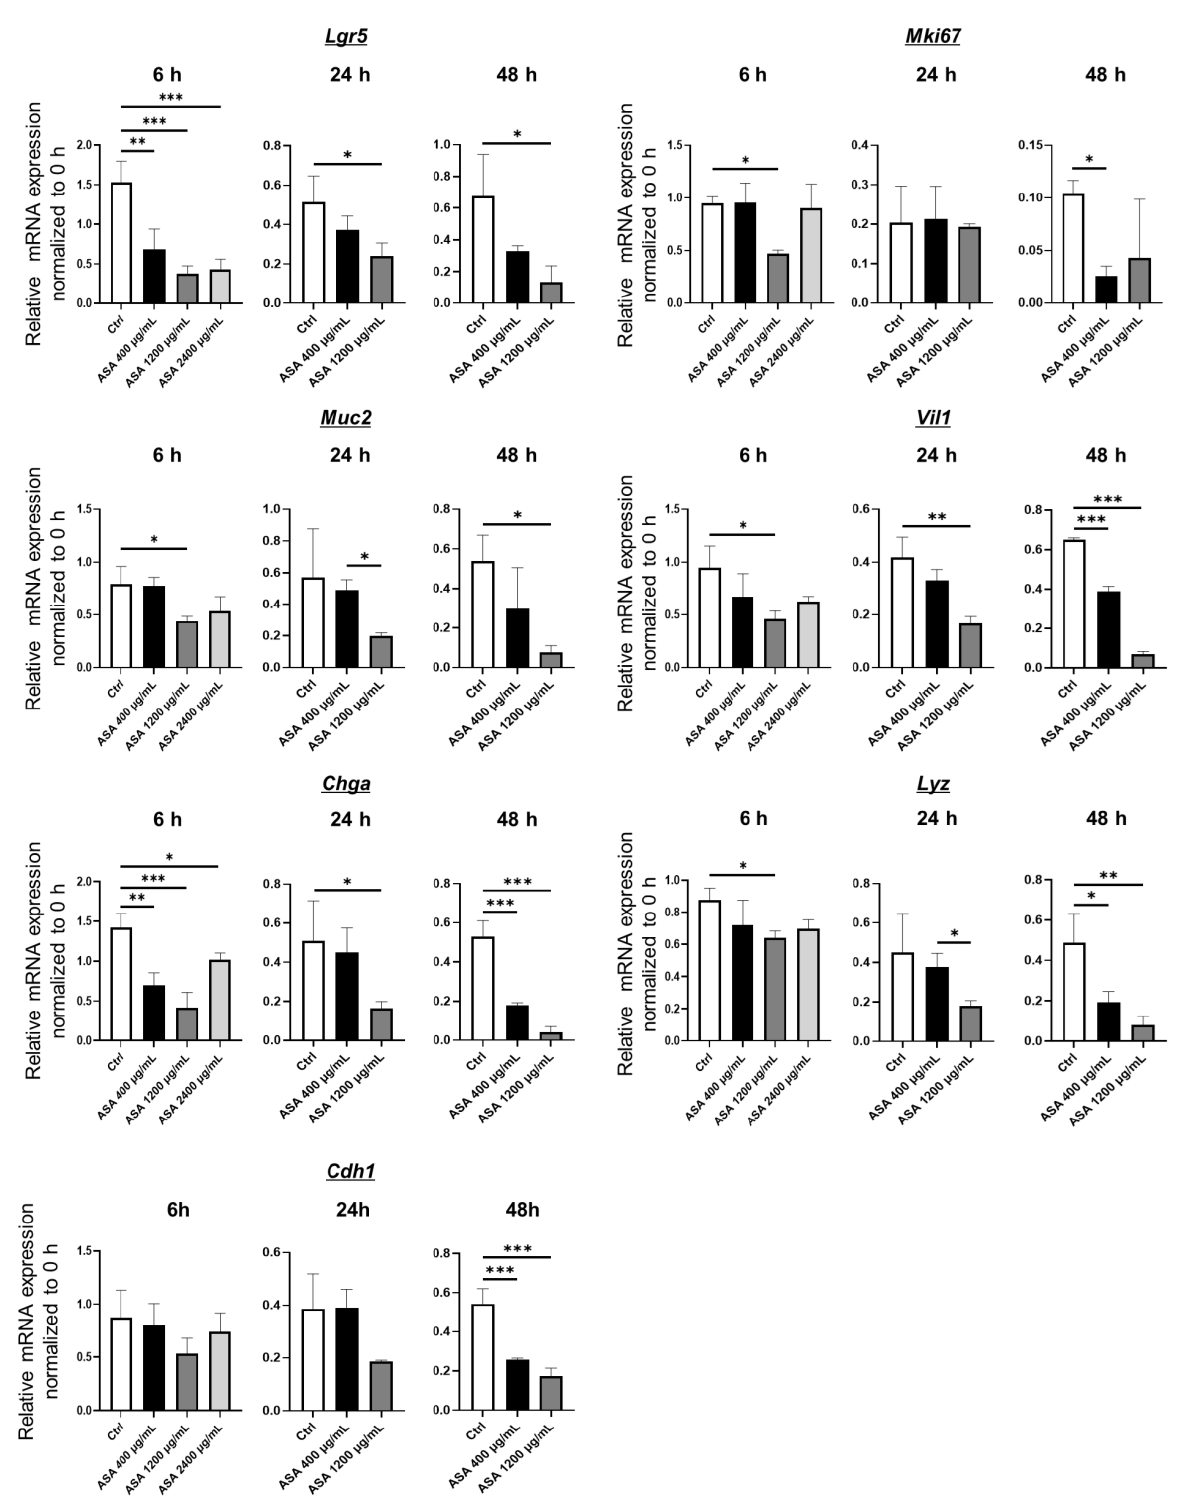
Figure 3. Real-time quantitative RT-PCR analysis of intestinal epithelial cell markers in ASA-injured 2D-hiPSC-SI. ASA-injured 2D-hiPSC-SI showed decreased mRNA expression of multi-lineage small intestinal cell and ISC markers. Data show mean ± SD; n = 3. Statistical analysis was performed using two-tailed Dunnett’s test; * p < 0.05, ** p < 0.01, *** p < 0.001. ASA: acetylsalicylic acid.